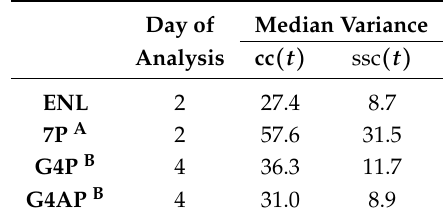
Table 3. Median variance of cc ( t ) and ssc ( t ) for the second generation Medtronic Paradigm Veo Enlite (ENL) sensor and the Dexcom SEVEN PLUS (7P), G4 PLATINUM (G4P), and advanced G4 for artificial pancreas studies (G4AP) sensors.